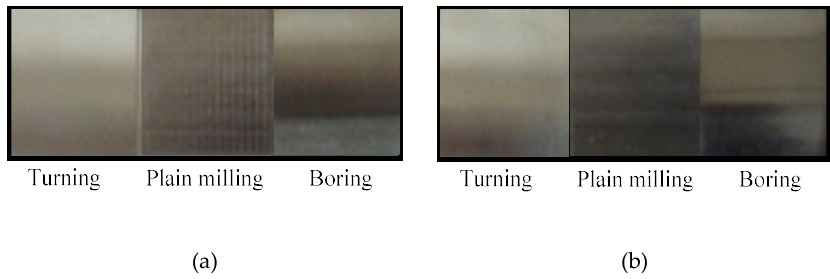
Figure 5. Machined sample surfaces: ( a ) Ra 3.2 sample surface; ( b ) Ra 0.8 sample surface.